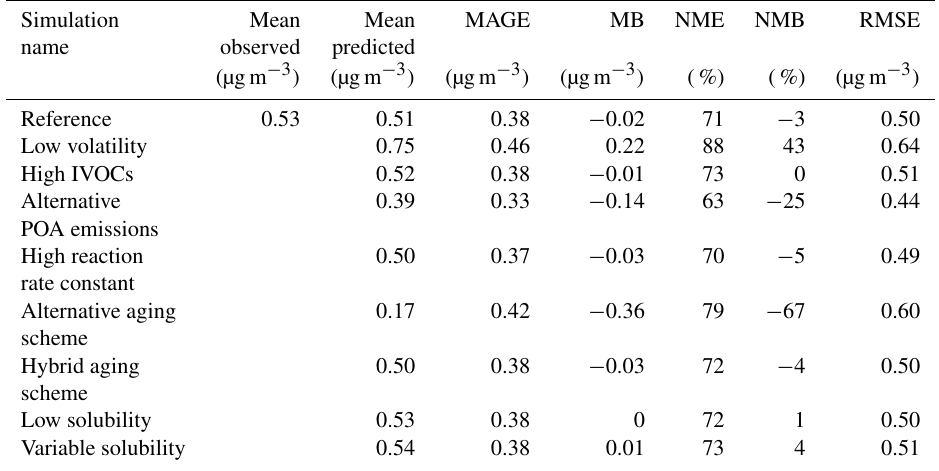
Table 2. Statistical evaluation of EMAC POA (sum of f POA and bbPOA) against AMS POA (sum of HOA and bbOA) using 61 datasets in urban-downwind and rural areas during 2001–2010.